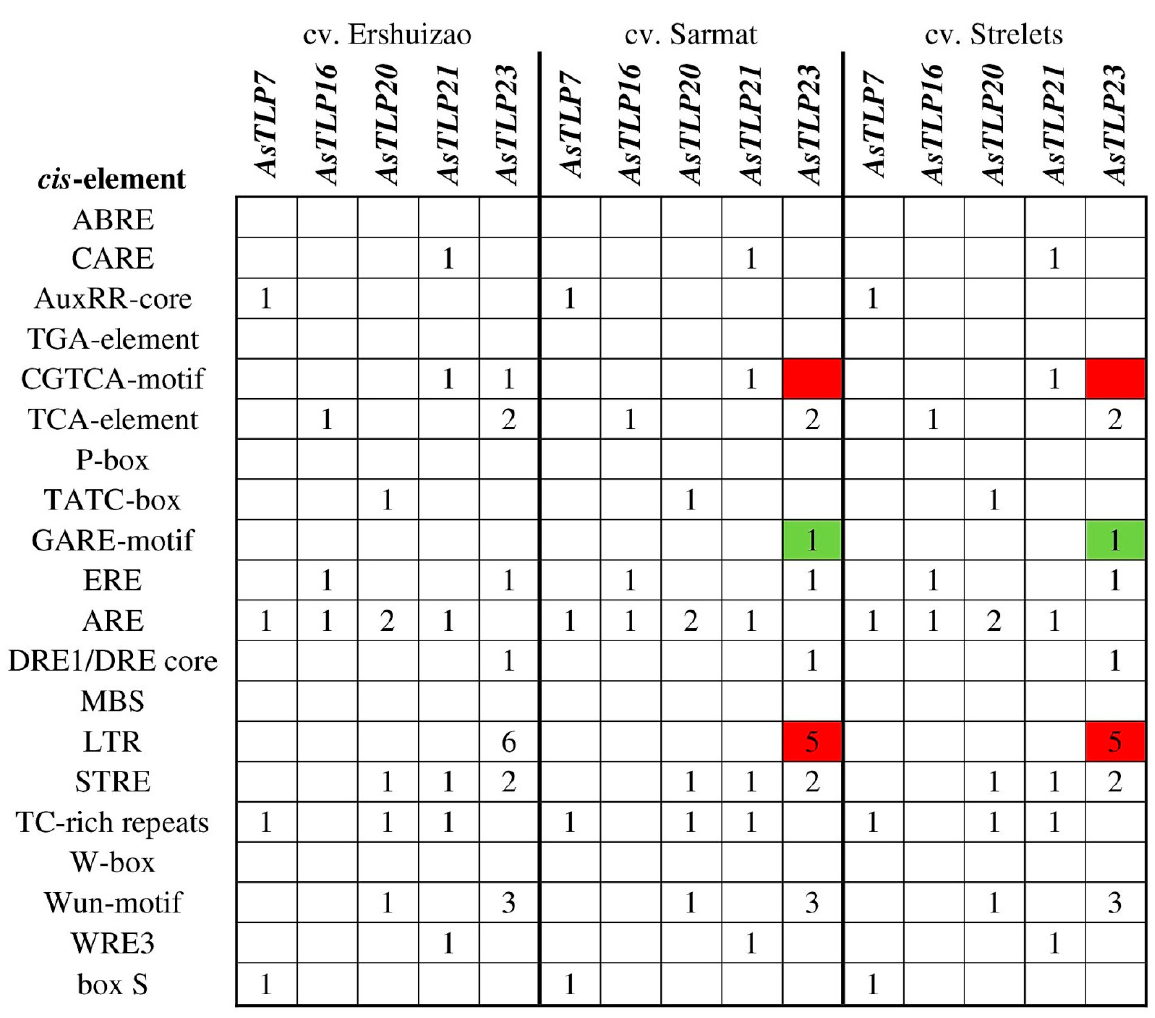
Figure 8. Comparative analysis of hormone- and stress-related cis -elements in the promoter regions of AsTLP7 , AsTLP16 , AsTLP20 , AsTLP21 , and AsTLP23 genes in A. sativum cv. Ershuizao, cv. Sarmat, and cv. Strelets. The numbers of cis -elements are indicated. The elements present in cv. Sarmat and cv. Strelets but absent in cv. Ershuizao are highlighted green and those present in cv. Ershuizao but absent or less abundant in cv. Sarmat and cv. Strelets are highlighted red.